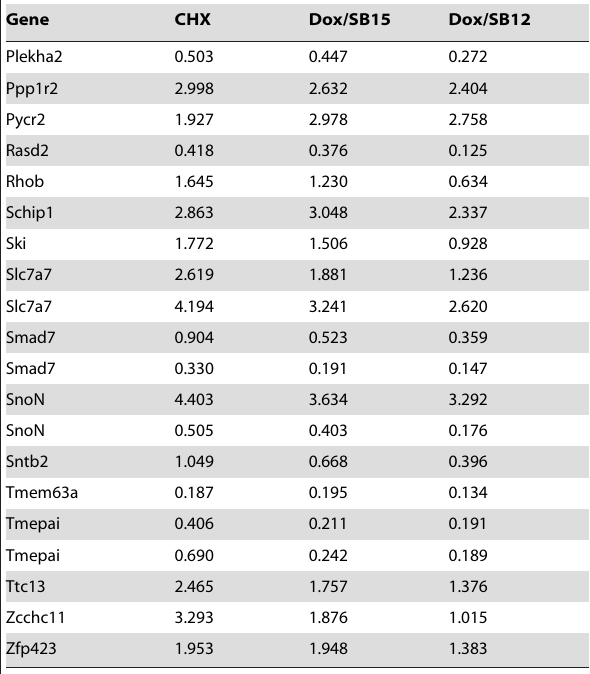
Table 2. Basal levels of expression of Smad2/3 target genes in ES